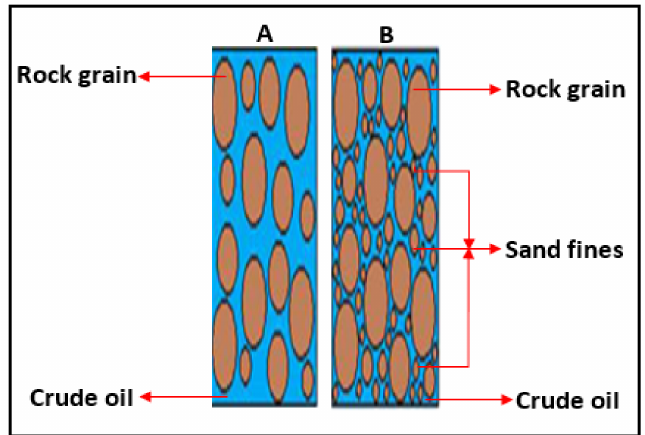
Figure 2. Pore arrangement of a very well sorted reservoir ( A ) with no clay/fine sand contents and a very poorly sorted reservoir ( B ) with much clay/fine sand contents. Modified after